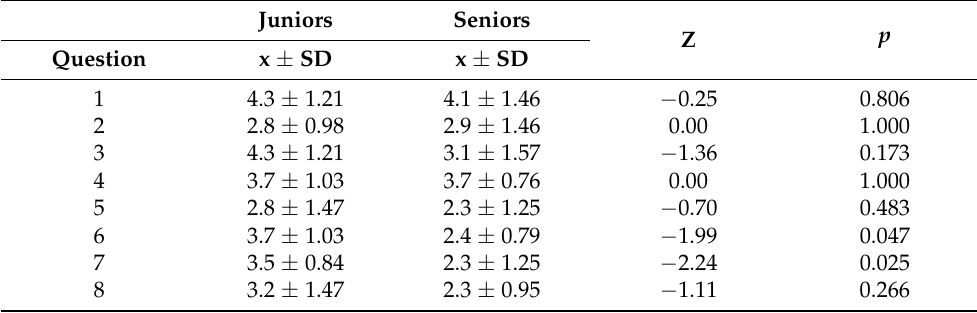
Table 3. Average values and standard deviations for questions 1 to 8, in junior and senior group and the analysis of differences (Mann–Whitney’s test) between Table 2. Spearman’s rank correlations coefficients between answers from the questionnaire (Q1– Q8) and competition experience as well as sports level.